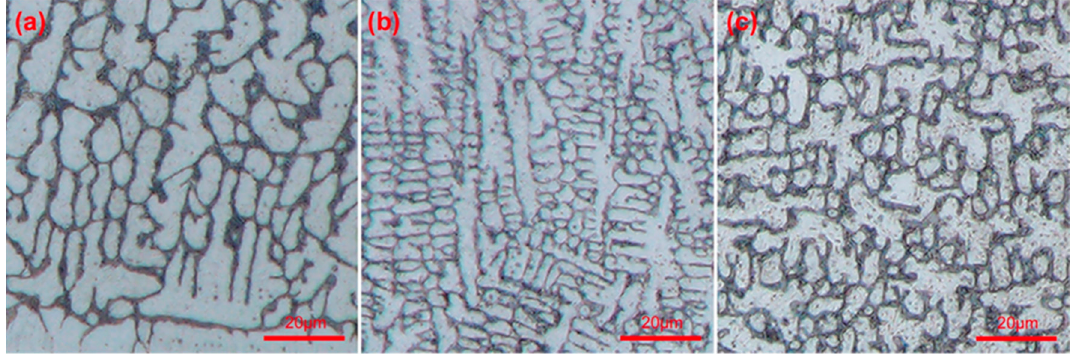
Figure 3. Cross-section microstructure of laser cladding specimen under optical microscope (OM) in: ( a ) bottom region; ( b ) middle region; ( c ) upper region.